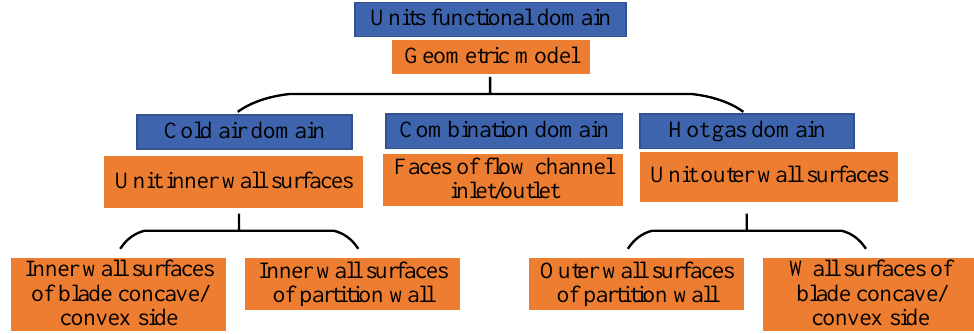
Figure 28. Blade functional and geometric domain